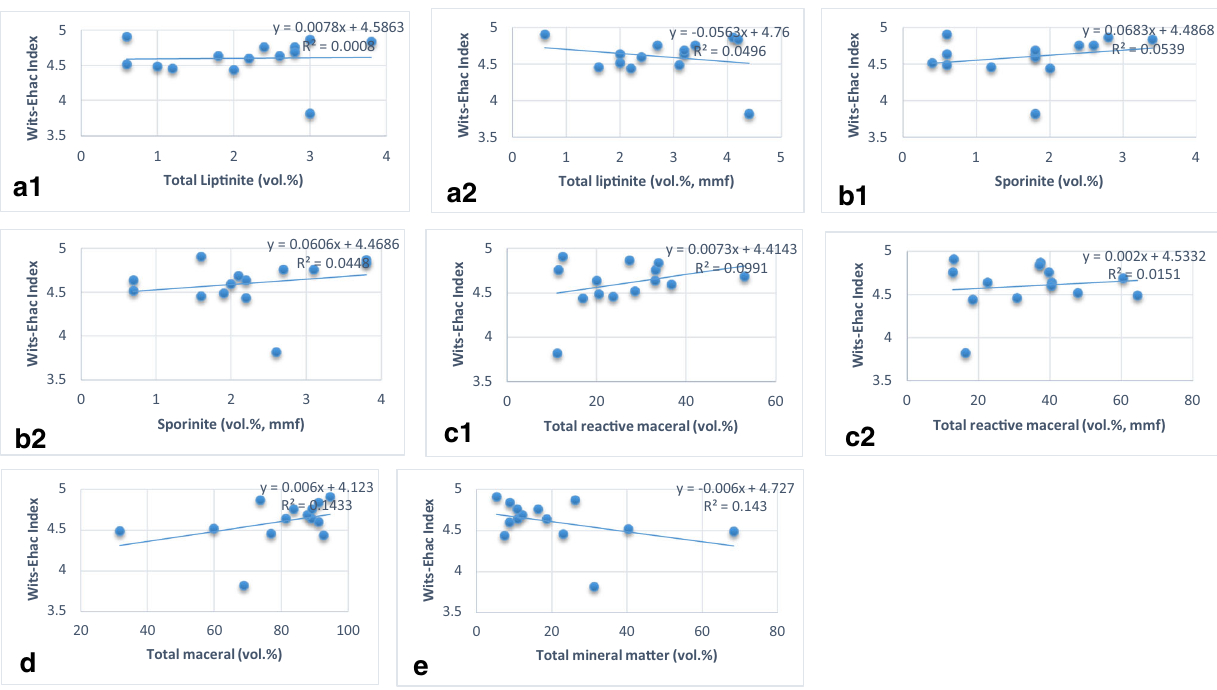
Fig. 13 Influence of liptinite, other macerals, petrographically observable mineral matter on spontaneous combustion of coals